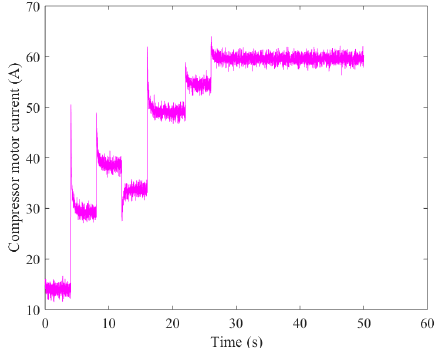
Figure 8. Compressor motor current changes with time.